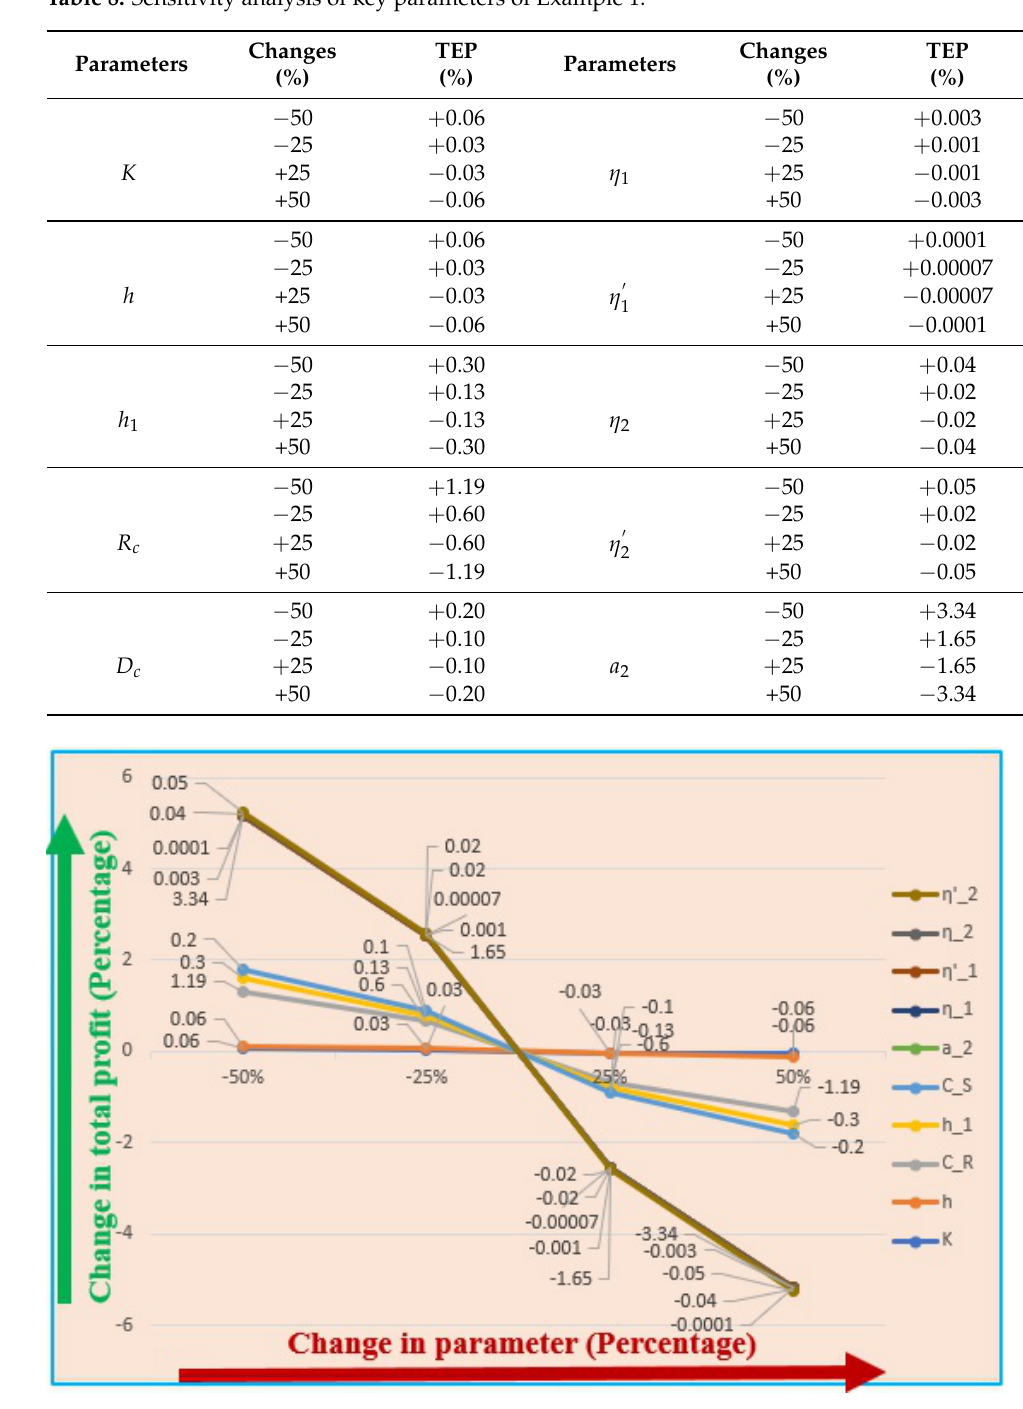
Figure 7. Changes in total profit versus parametric